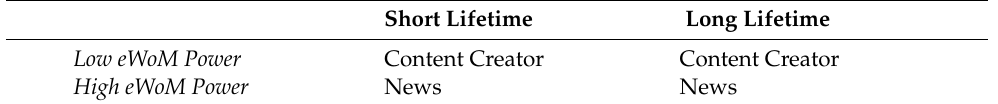
Table 14. Categorization of the posts associated with the lifespan template “Unlucky”.